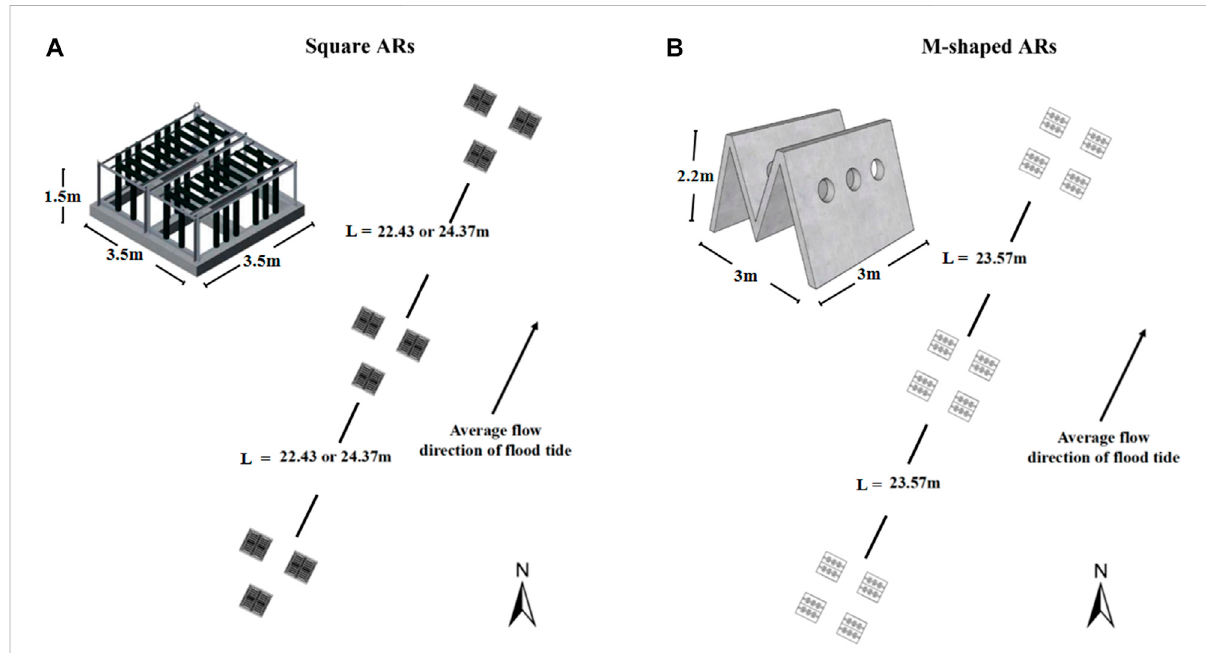
FIGURE 2 Square (A) and M-shaped (B) arti fi cial reefs placed in the pilot site with three and four reefs making up the respective unit group, black arrow highlights fl ow